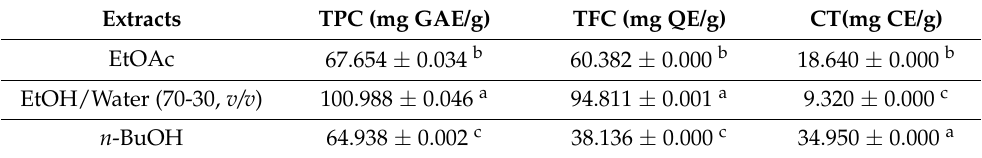
Table 1. Chemical composition of A. arboreum leaf